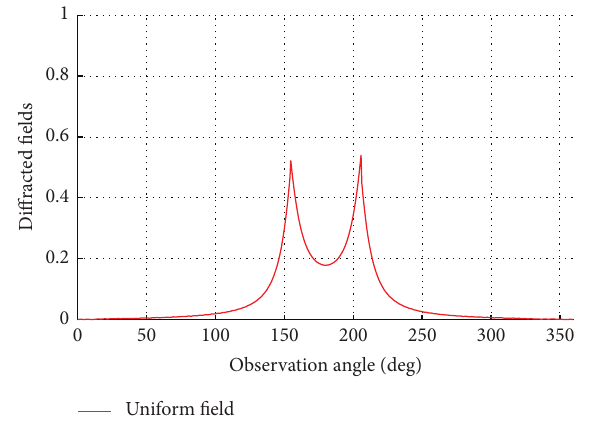
Figure 3: The uniform solution at 𝜙 0 = 𝜋/7 .